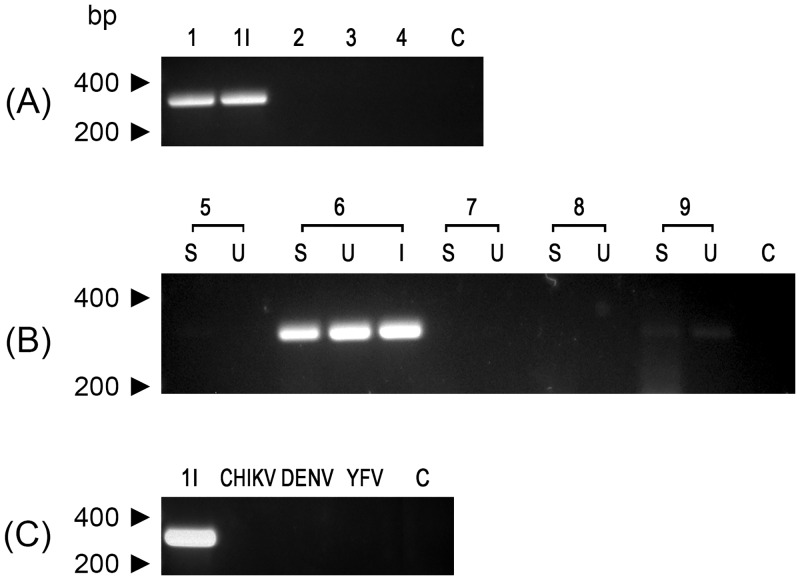
Detection of genomic RNA of Zika virus in urine and saliva samples by RT-PCR analysis.(A) Shows the profiles obtained from urine samples. The lane numbers indicate the patient code. The lane 1I is the amplicon obtained from the viral isolate from urine of patient 1 (isolate Rio-U1). (B) RT-PCR analysis from patients 5 to 9 where S indicates saliva RNA samples, U, urine RNA samples, and I viral isolate sample. (C) Amplification of Zika virus genome of isolate Rio-U1 (1I) with ZIKV-specific primers that were also employed in the RT-PCR assay of Chikungunya virus RNA (CHIKV), dengue virus RNA (DENV) and Yellow Fever 17DD RNA (YFV). In all of these analyses, a negative control of amplification were included (C). The size marker migration is indicated on the left of the figures.